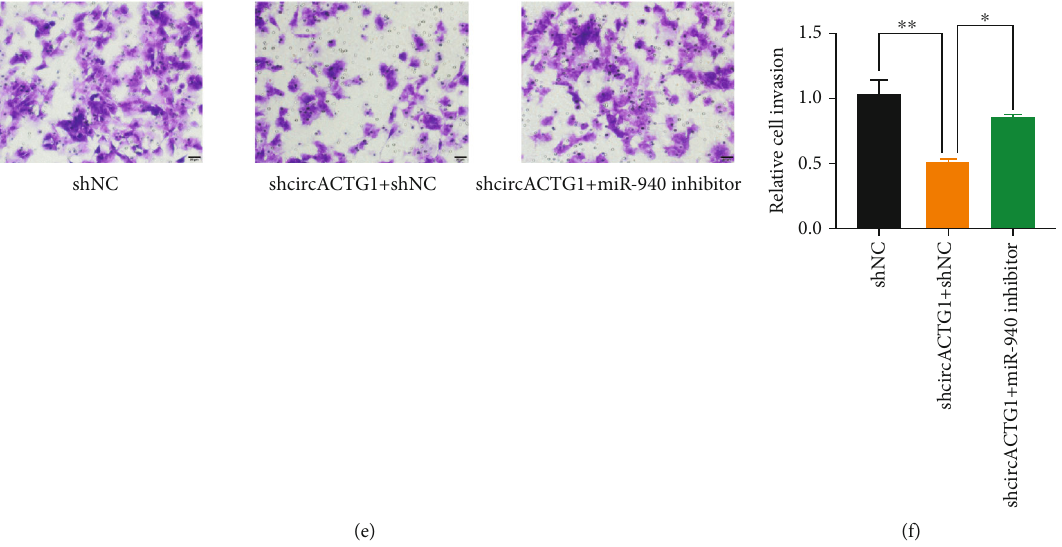
Figure 4: miR-940 rescued the function of circACTG1 in 97H cells with circACTG1 knockdown. (a) circACTG1 knockdown could signi fi cantly promoted the expression of miR-940, while it was partially inhibited when combined with miR-940 inhibitor. (b) Proliferation abilities of 97H cells with circACTG1 knockdown or combined with miR-940 inhibitor were tested by CCK8 assay. (c) Proliferation abilities of 97H cells with circACTG1 knockdown or combined with miR-940 inhibitor were detected by clone formation assay. (d) Invasion abilities of 97H cells with circACTG1 knockdown or combined with miR-940 inhibitor were detected by transwell